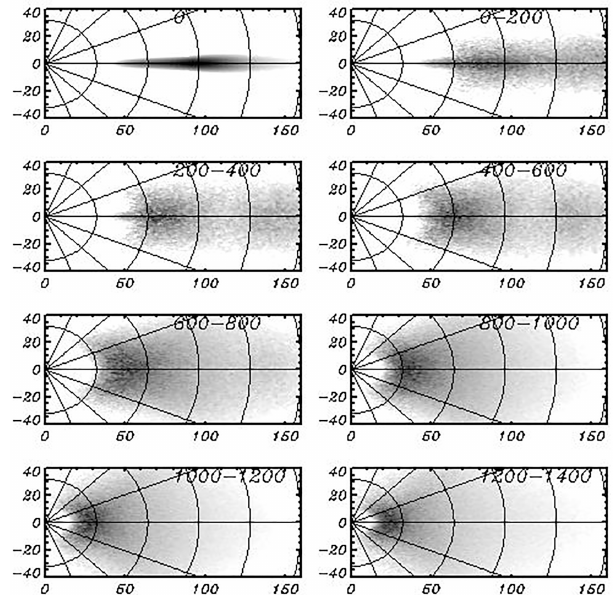
Figure 6. Sequence of 2-D images of lg 10 (S(k,l)) averaged over the consequent seven periods of length (cid:49)t = 200. The numbers in- dicate the period of averaging (first panel marked 0, refers to the initial conditions). The horizontal and vertical axes correspond to the wave numbers k and l ,